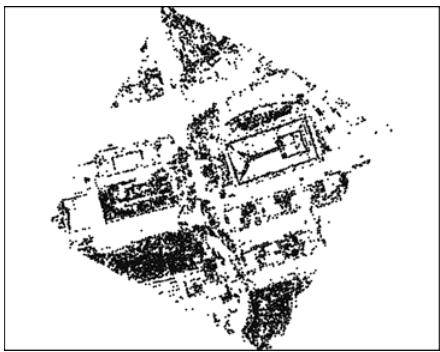
Figure 8. Grid cells of final matching results